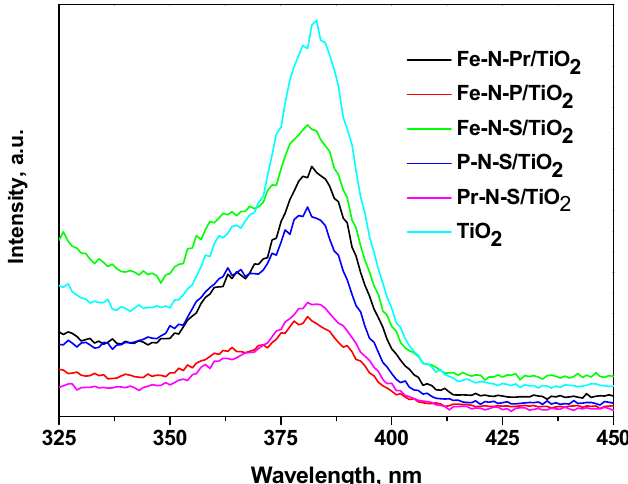
Figure 5. PL spectra of all the prepared samples.